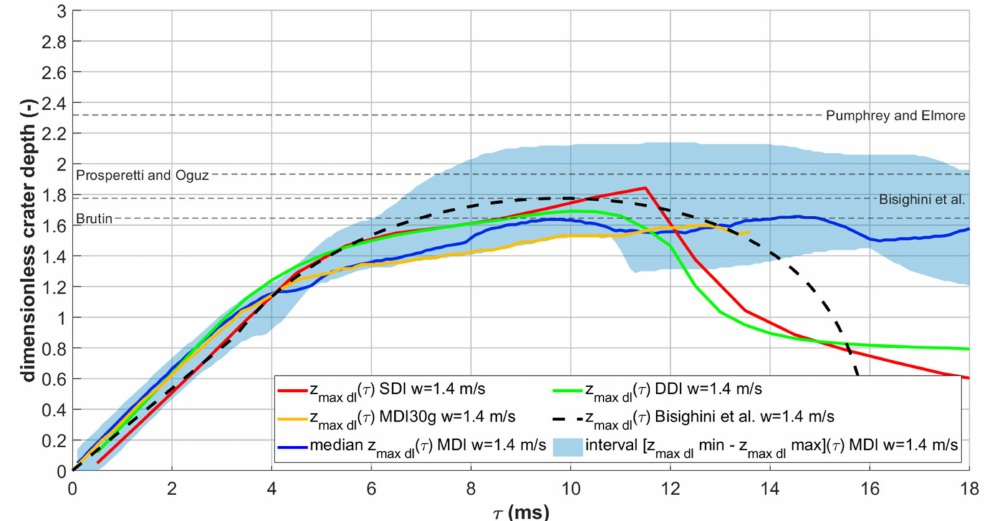
Figure 7. Dimensionless crater depth as a function of time for single, double, and multiple drop impacts at 1.4 m/s. Predictions from some of the most credited literature models are also